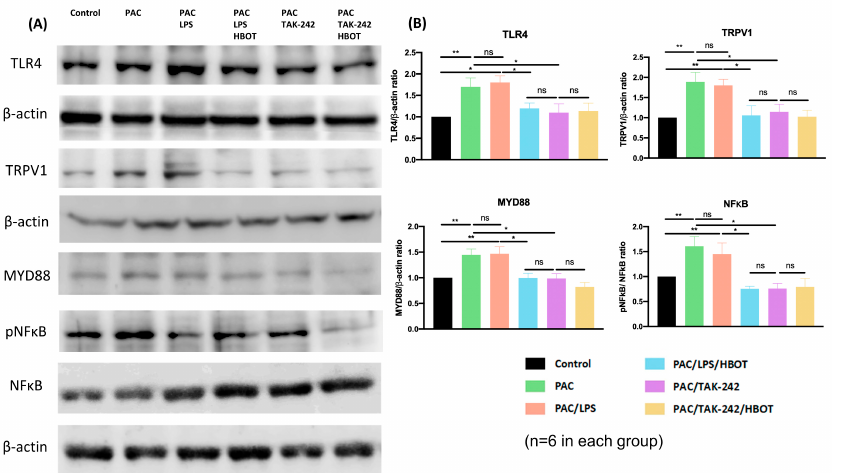
Figure 4. The expression of TLR4, TRPV1, MyD88, pNF- κ B and NF- κ B in the rat spinal cord dorsal horn. ( A ) Western blotting analysis of TLR4, TRPV1, MyD88, pNF- κ B and NF- κ B. ( B ) Representative bar graphs illustrating the quantitative analysis of Western blotting results. Significantly increased expression of TLR4, TRPV1, MyD88 and pNF- κ B/NF- κ B in the PAC and PAC/LPS groups compared to other groups. Each bar represents mean ± SEM ( n = 6 per group). * p < 0.05, ** p < 0.01, ns: not significant.